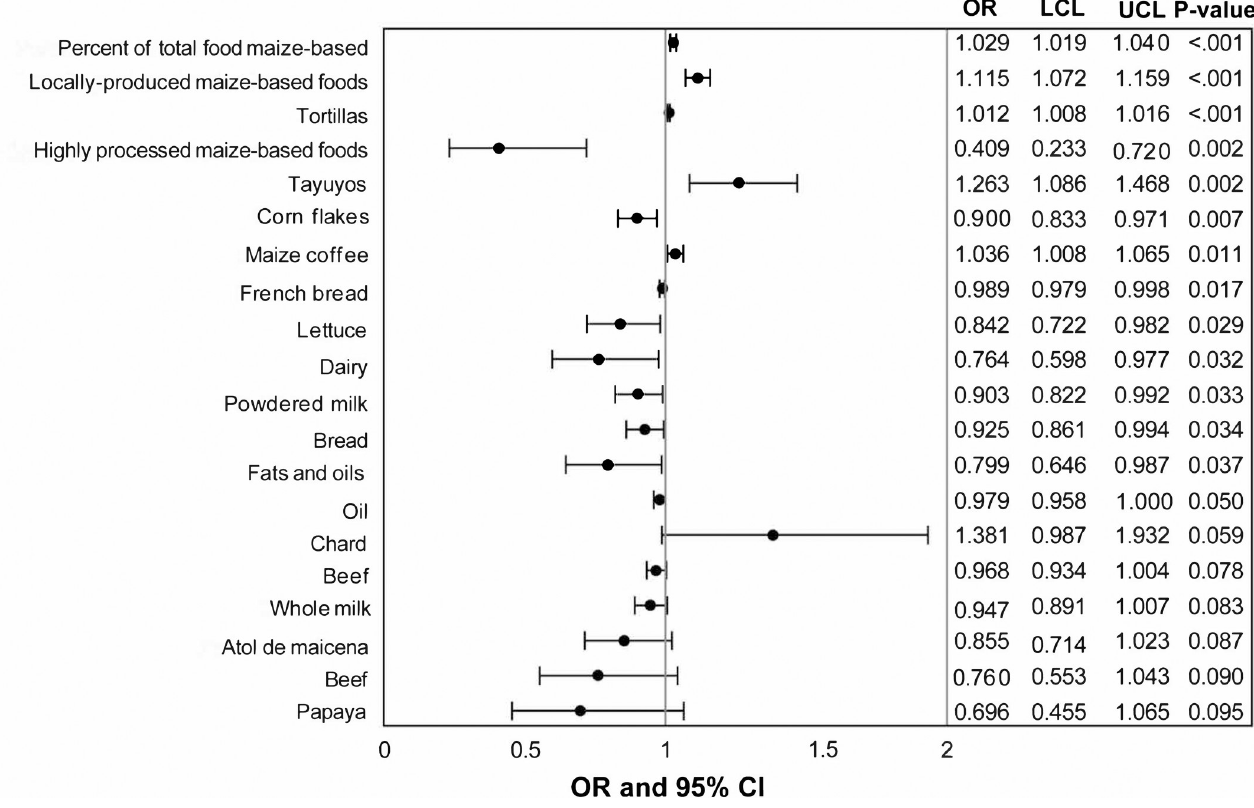
Fig 4. Dietary factors associated with uFB 1 exposure group in univariable analysis. Unit is servings unless otherwise noted. Odds ratios (OR), upper (UCL) and lower (LCL) 95% confidence levels, and p-values from logistic